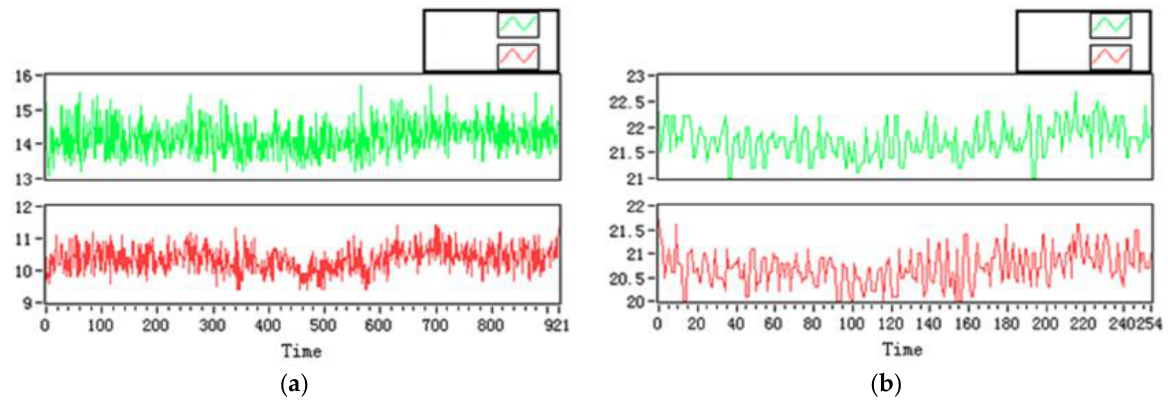
Figure 22. The oil film thickness test curve of the port plate pair. ( a ) The oil film thickness at the oil inlet of the port plate pair; ( b ) the oil film thickness of the oil outlet. The green lines represent the oil film thickness measured on the upper side of the kidney slots. The red lines represent the oil film thickness measured on the lower side of the kidney slots.